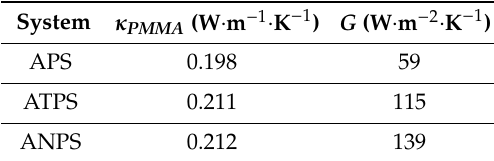
Table 2. Best fit values for κ PMMA and G for the three systems APS, ANPS and ATPS are summarized below. The values reported are subject to a 10% total experimental